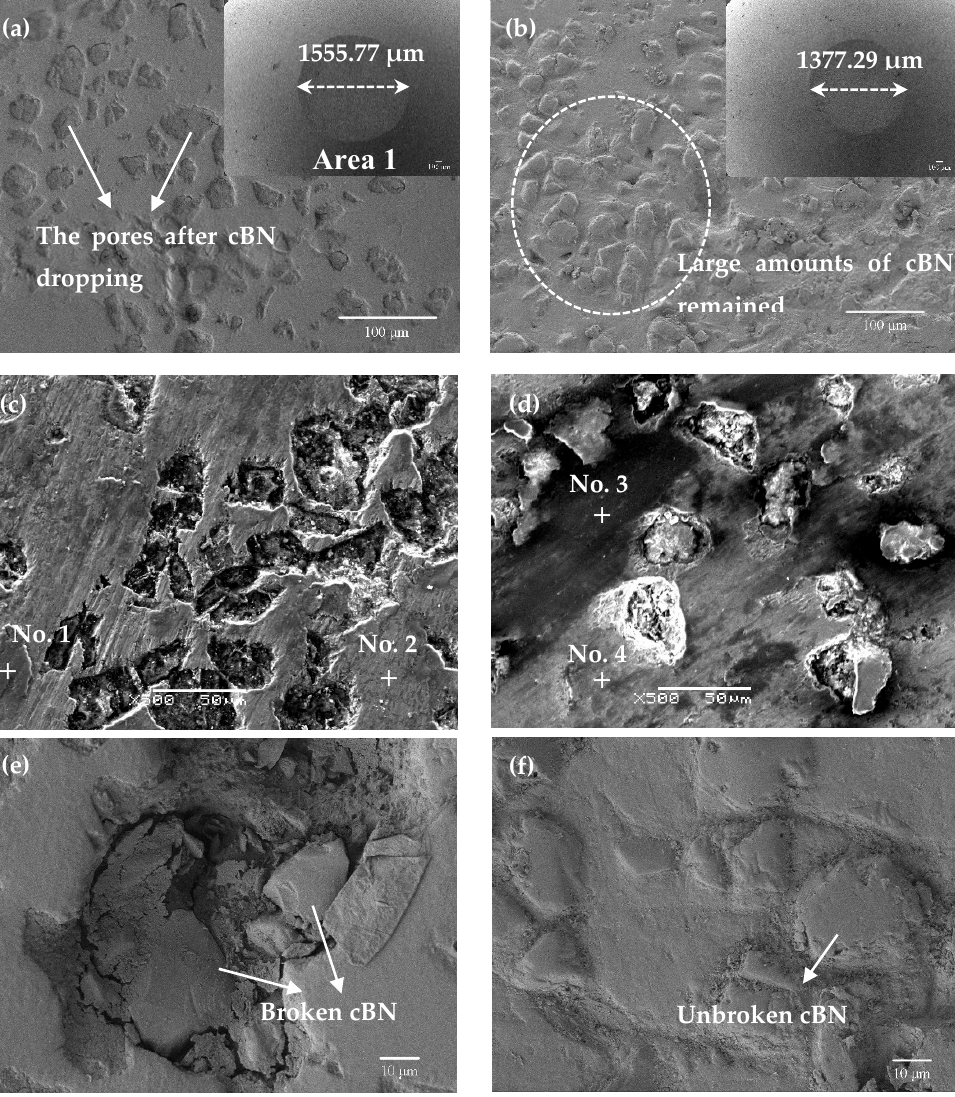
Figure 11. SEM images of the worn surface: ( a , c , e ) cBN/Ti6Al4V composite coating; ( b , d , f ) NicBN/Ti6Al4V composite coating. Table 3. Elemental concentrations (wt.%) of the selected areas of the worn surface using EDS. Elements(wt.%)